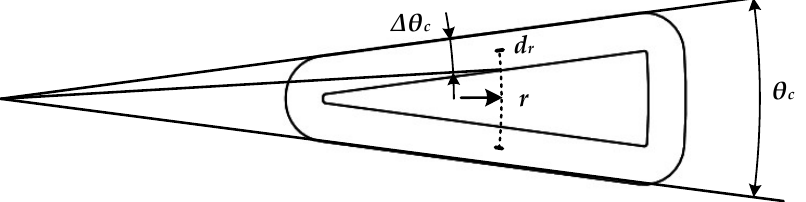
Figure 3. Layout of concentrated non-overlapping coil stator windings for the SCM-AFPM motor.